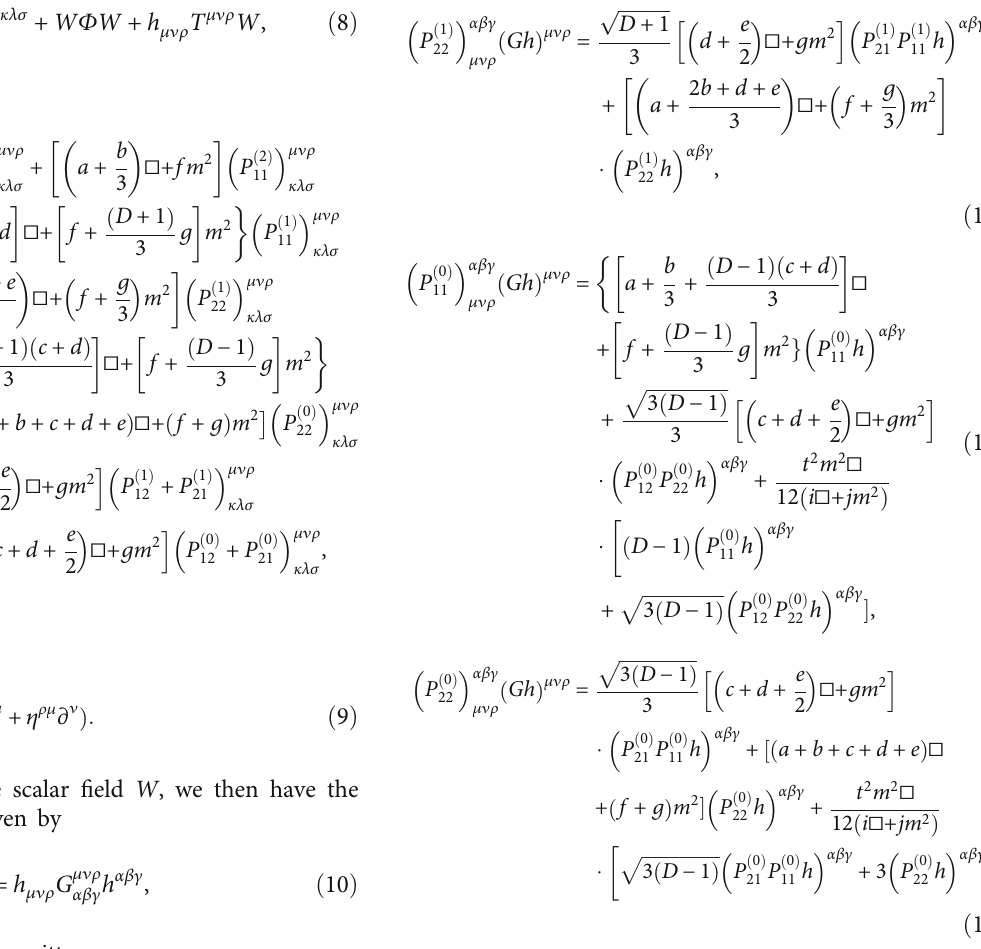
ffiffiffiffiffiffiffiffiffiffiffi